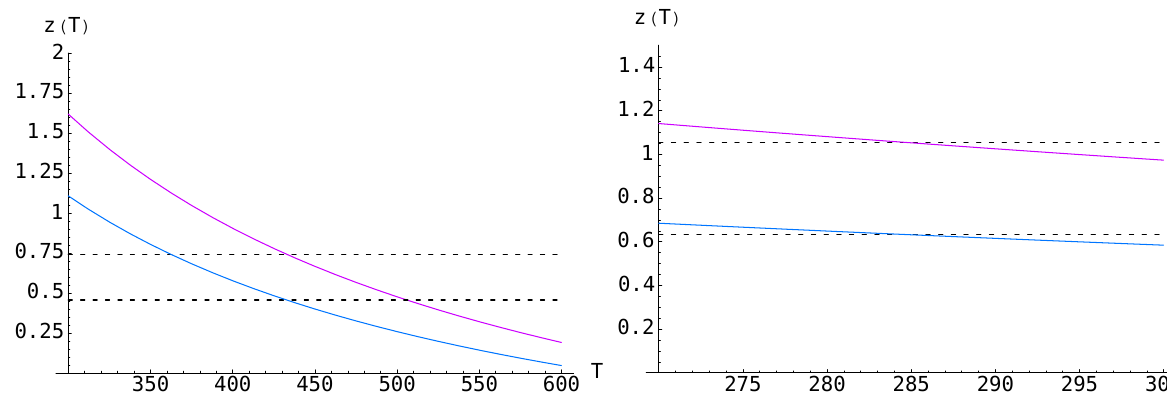
Figure 3. Optimal figure of merit z and colours see the legends of Figures 1 and